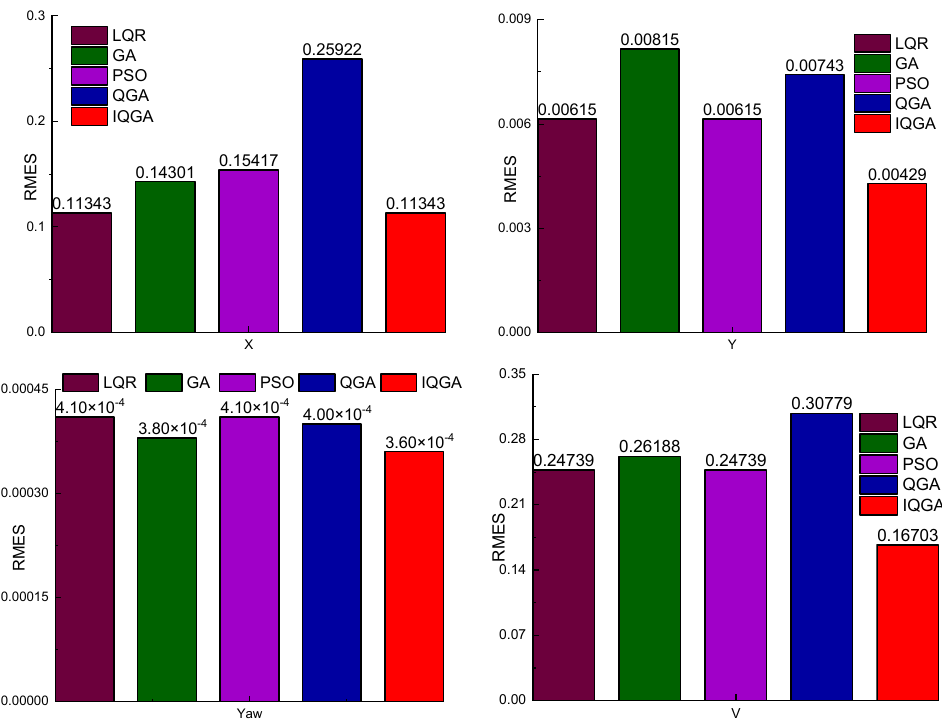
Figure 9. Motion state RMSE values when tracking circular trajectories.